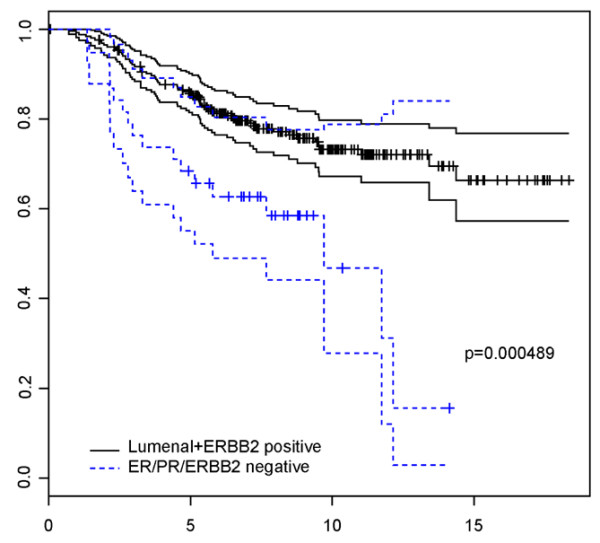
Survival analysis of the two sample clusters identified from the cancer data set [8]. The clusters were generated from the normal breast tissue signature. The estrogen receptor (ER)/progesterone receptor (PR)/ERBB2 negative cluster consisting of 38 samples shows poor survival compared to the remaining samples consisting of Lumenal and ERBB2 positive tumors (p = 0.000489).